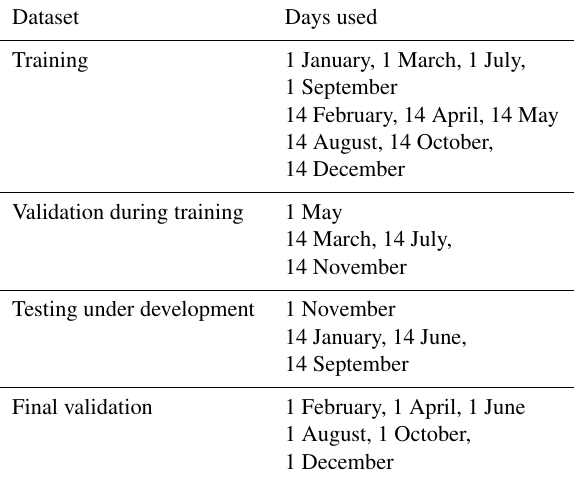
Table 1. MODIS data from 2010 used for training and validation of the neural